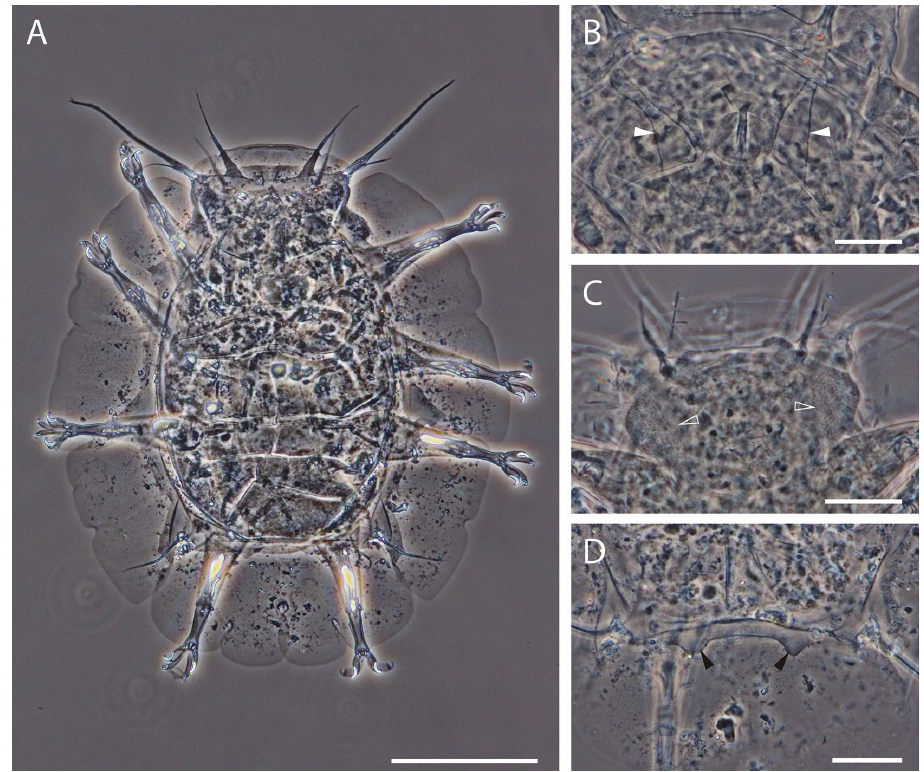
Figure 3. Phase contrast micrograph of Florarctus wunai sp. n. A dorsal view, holotype KUZ Z705, scale bar = 100 μm B secondary clavae (white arrowhead), holotype KUZ Z705, scale bar = 20 μm C bacterial vesicles (white, hollow arrowhead), paratype KUZ Z709, scale bar = 20 μm D caudal alae caestus with pair of small projections (black arrowhead), paratype KUZ Z708, scale bar = 20 μm. 25 μm from frontal margin. Pair of external cirrus (44 μm) with scapus (18 μm), tubular portion (20 μm) and flagellum (6 μm) inserted ventrally 30 μm from